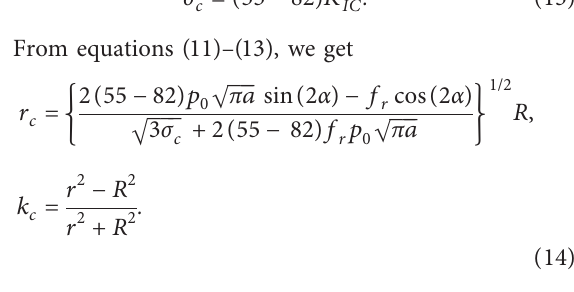
Figure 3: Crack propagation model under bidirectional com- pression: (a) initial crack and (b) wing crack